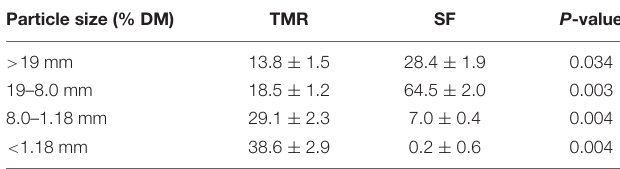
TABLE 2 | Feed Particle size distribution (%) in different feeding